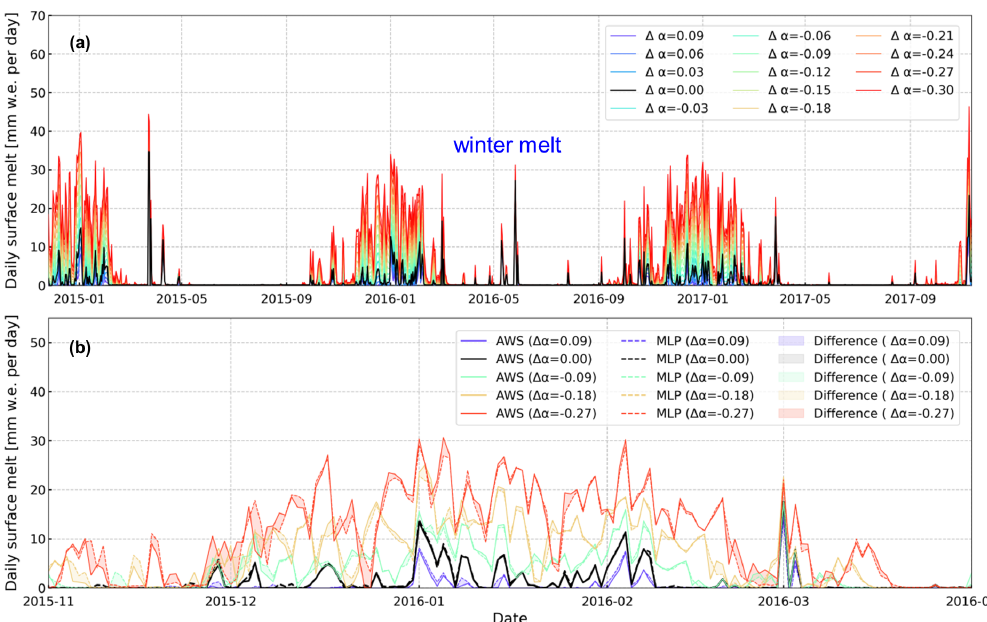
Figure 5. Temporal changes in the corrected regional atmospheric climate model version 2.3p2 (RACMO2) surface melt using the deep multilayer perceptron (MLP) model at automatic weather station (AWS) 18, (a) for all albedo differences ( (cid:49)α ) and (b) for a subset between November 2015 and April 2016 along with the augmented AWS observations for